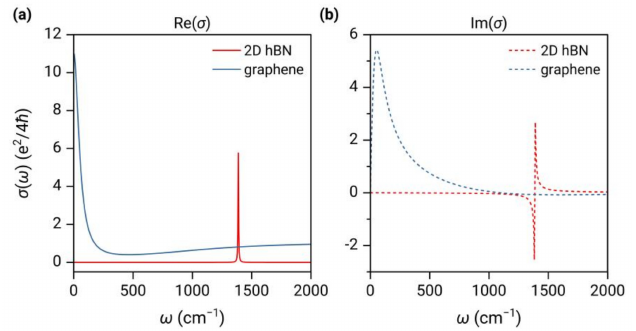
Figure 1. ( a ) The real parts and ( b ) the imaginary parts of the conductivity of graphene and 2D hBN as a function of frequency. The chemical potential of graphene is set to µ = 0.05 eV and the temperature is 300 K.